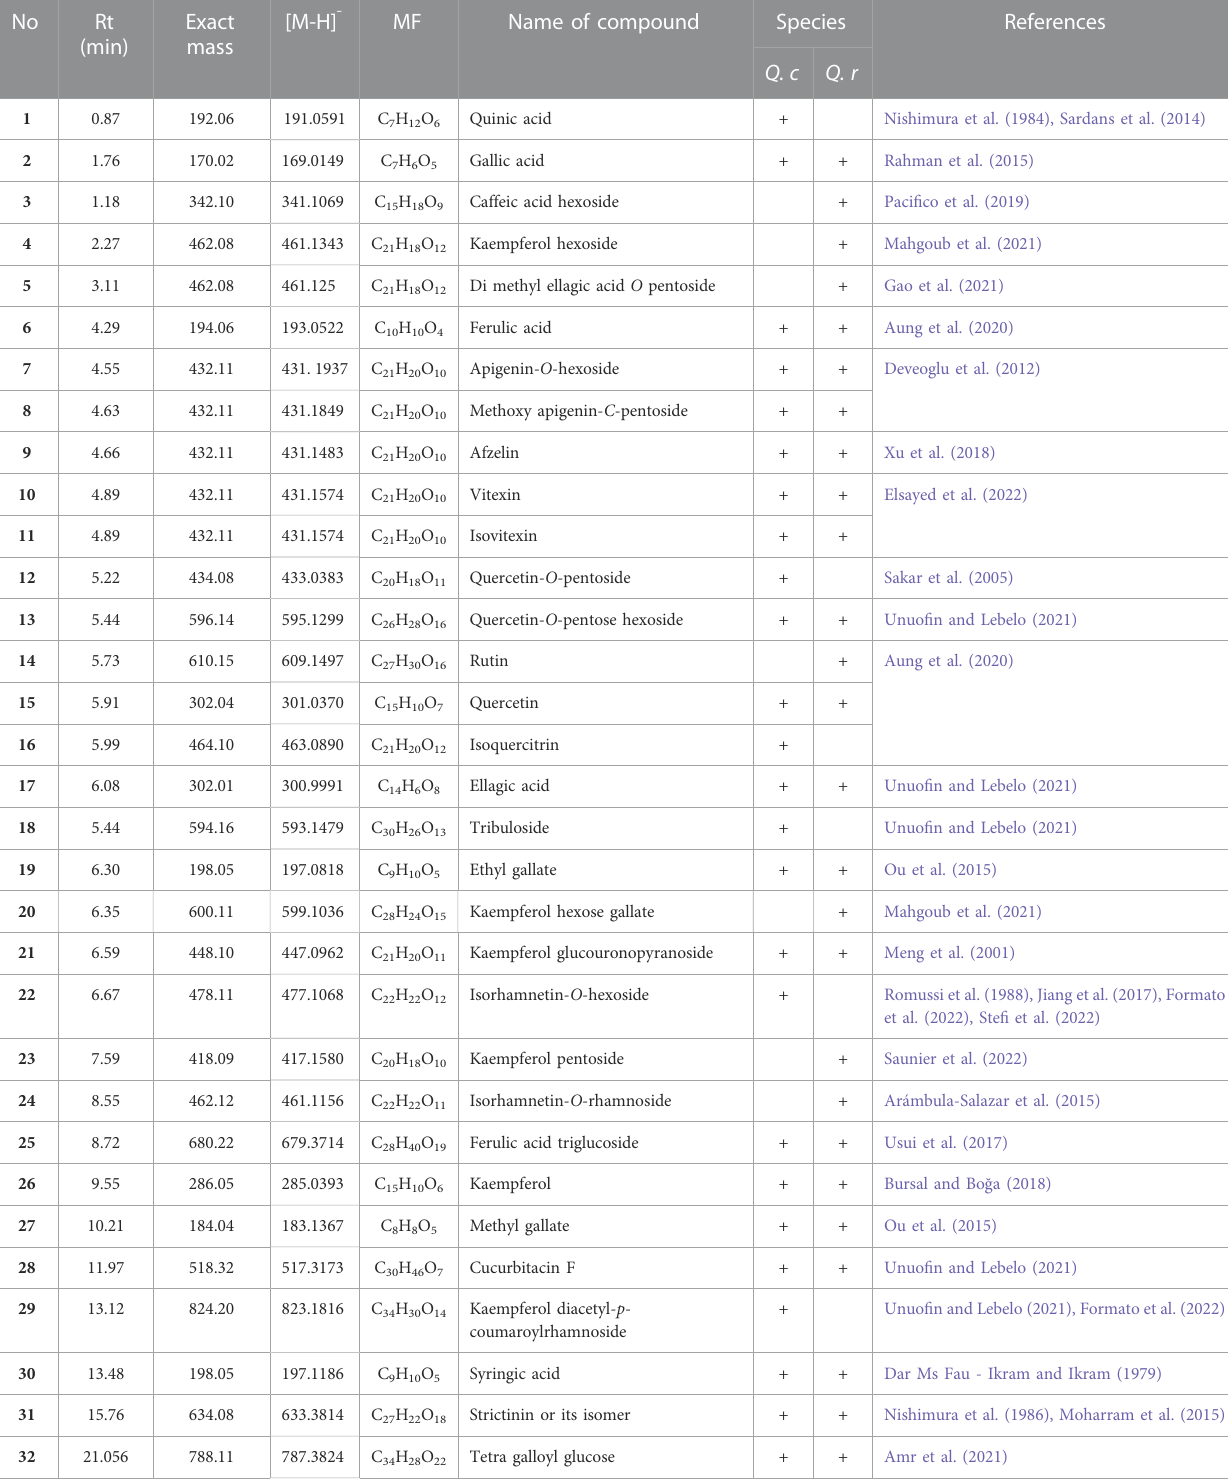
TABLE 1 UHPLC pro fi le tentative secondary metabolites identi fi cation for Q. coccinea and Q. robur leaves 80% aqueous methanol